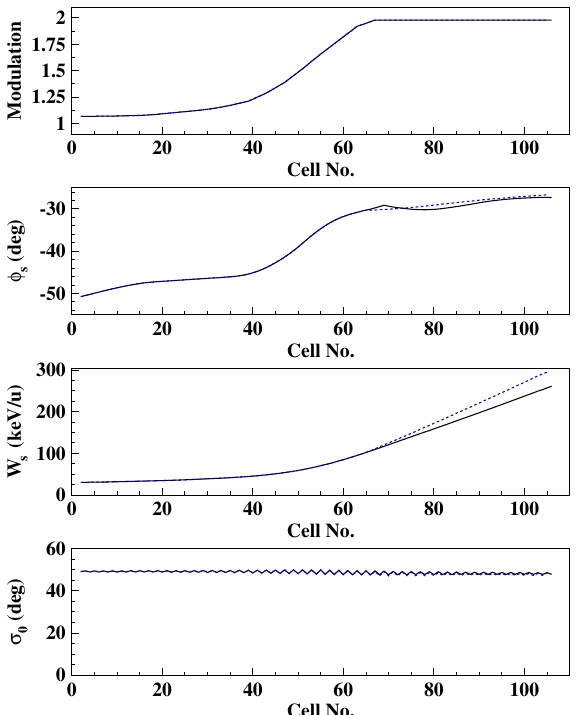
FIG. 5. Comparison of the RFQ design parameters between the original sinusoidal design (solid black) and the final trapezoidal vane modulation design (dashed blue).